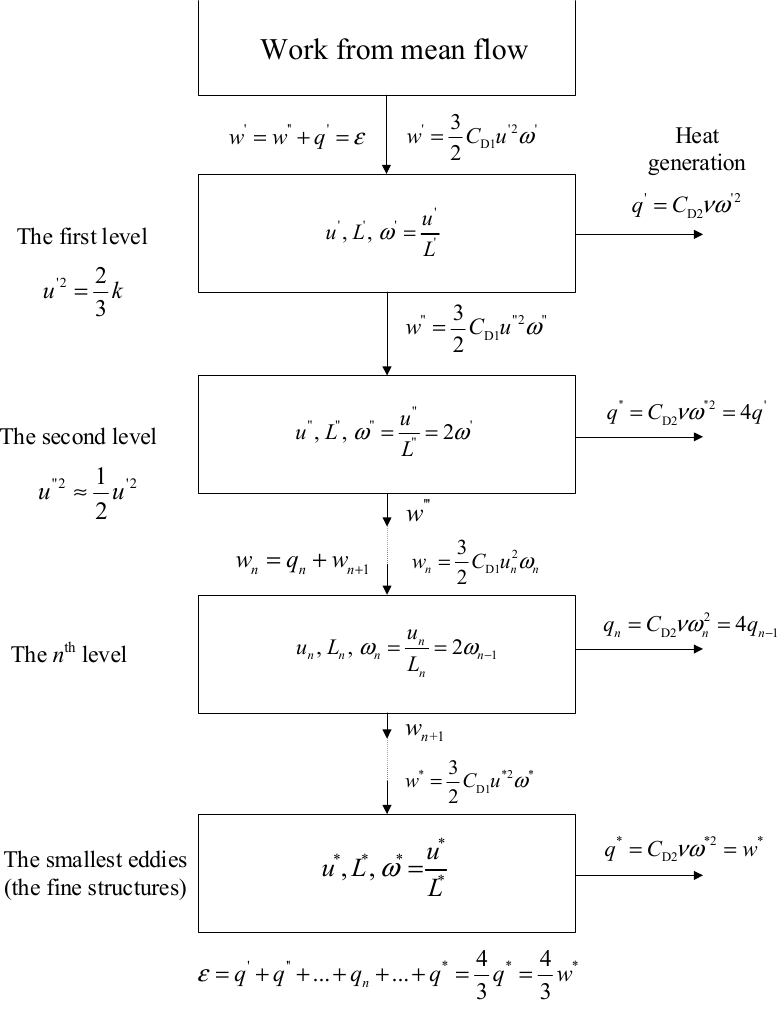
Figure 2. Energy cascade model for the transfer of mechanical energy from the mean flow, through turbulent energy, to heat. Reprinted with permission from Ref. [27]. 2022, Elsevier Ltd.